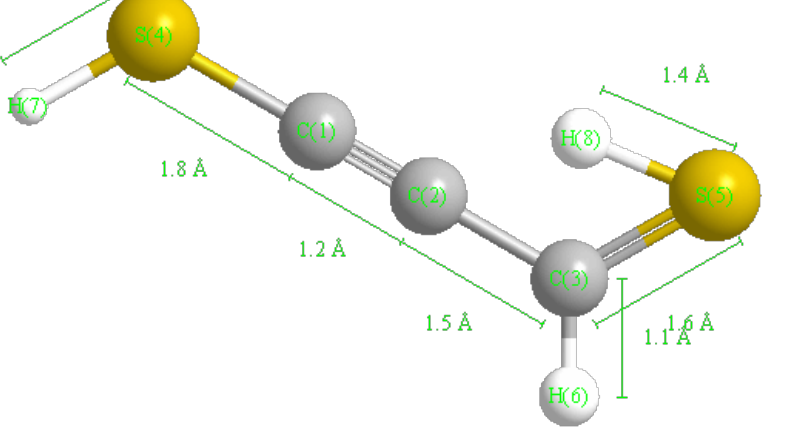
Figure 13. Single-crystal structure.